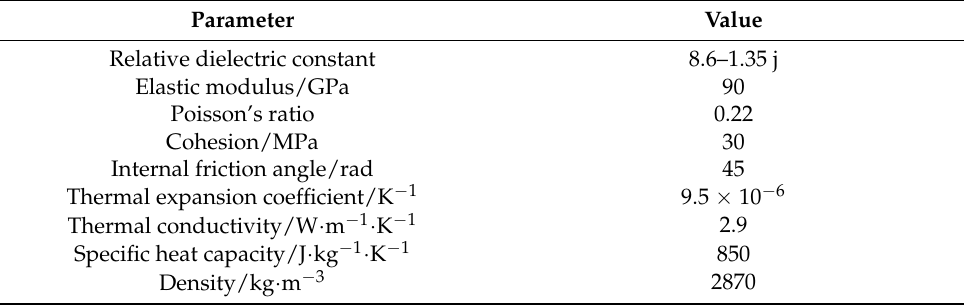
Table 1. Physical and mechanical parameters of